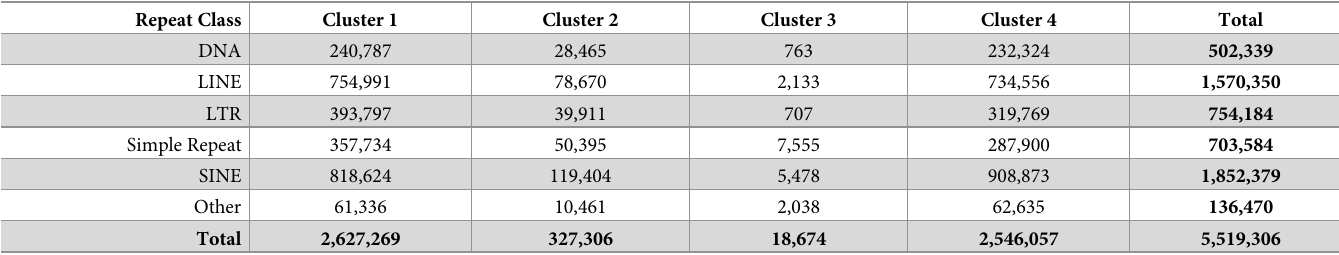
Table 5. Clustering of Repetitive Elements.